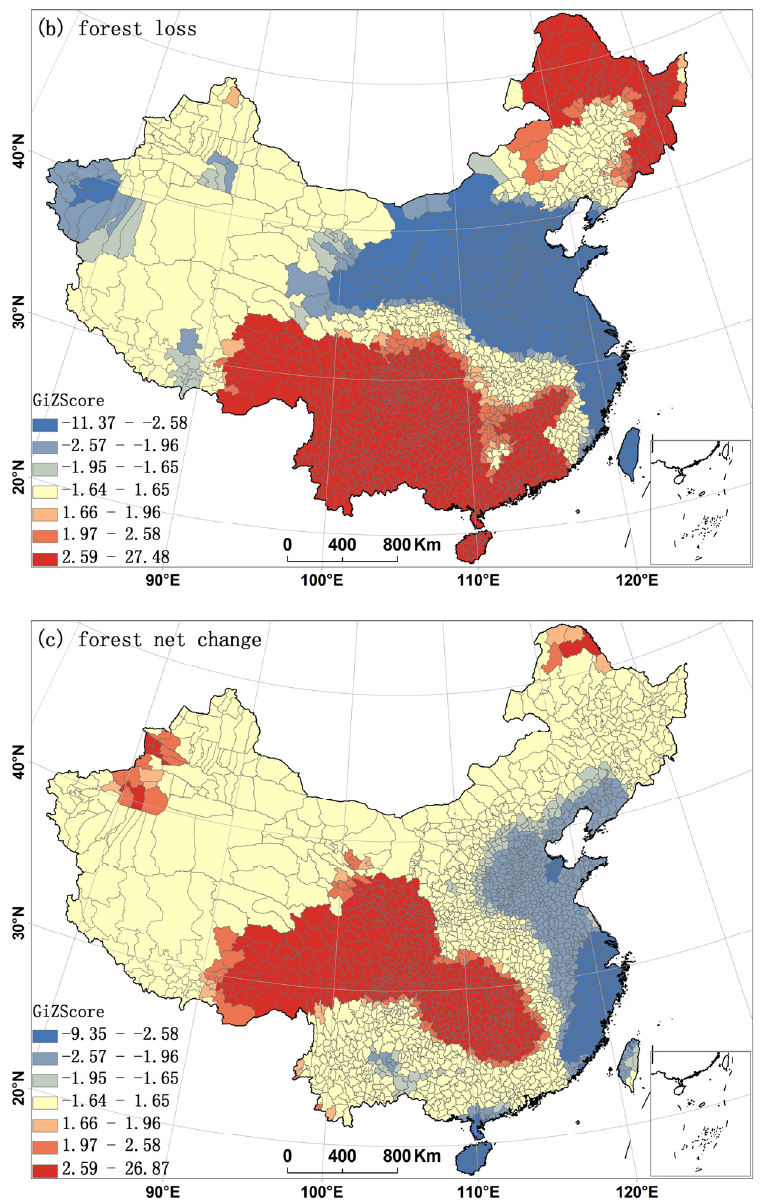
Figure 4. Hot and cold spots of forest area changes in China, 2000–2010: ( a ) forest gain; ( b ) forest loss; ( c ) forest net change. (Notes: Red regions represent hot spots and blue regions represent cold spots.)